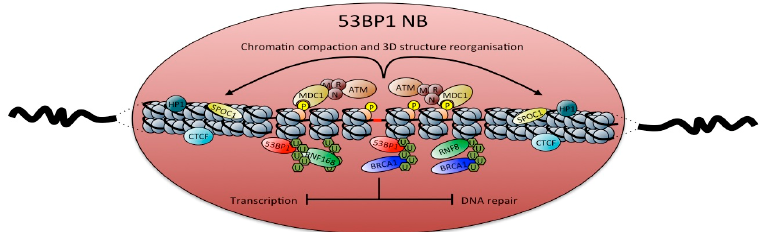
Figure 1. Composition of 53BP1 nuclear bodies. Unreplicated DNA from mother cell (red area) induces the accumulation of DDR signaling factors in G1 daughter cells (53BP1 (red), MDC1, MRN complex, ATM (brown), RNF8, RNF168 (green) and BRCA1 (blue), associated with histone H2A/H2AX ubiquitinylation (green U chains) and H2AX phosphorylation, i.e., γ H2AX (yellow circled P on nucleosomes). This in turn locally alters chromatin structure through the recruitment of the insulator protein CTCF (light blue) and enhances chromatin compaction mediated by SPOC1 (yellow) and HP1 (blue). Exclusion from 53BP1 NBs of RNA Pol II and DNA repair factors locally inhibits transcription and DNA repair, respectively.